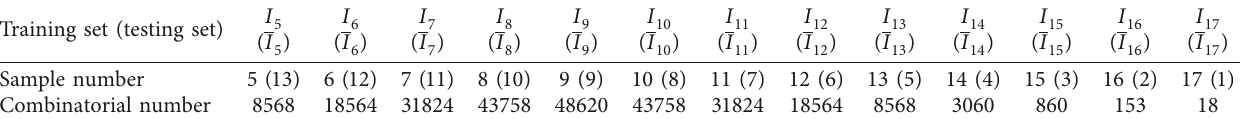
Table 6: Number of samples in each